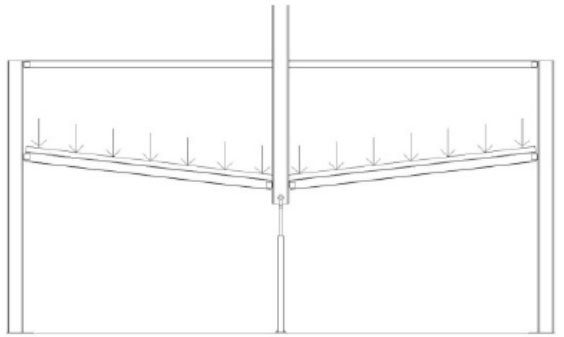
Figure 10. Lowering of central column to simulate column